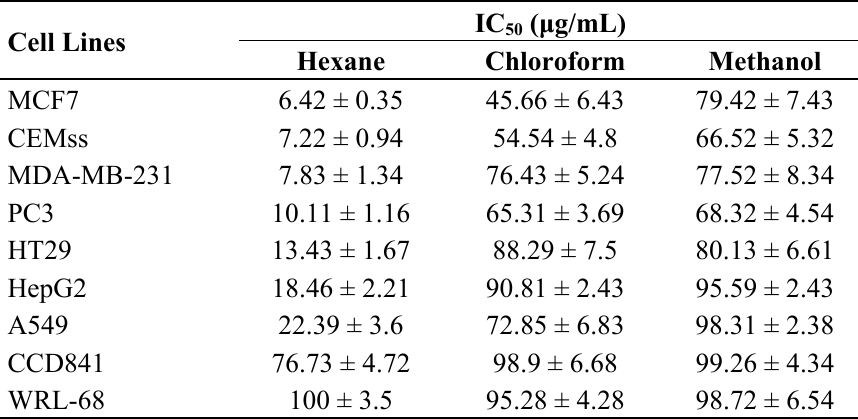
values of T. polycephalum leaves extracts on nine different cell lines after Table 1. IC 50 48 h